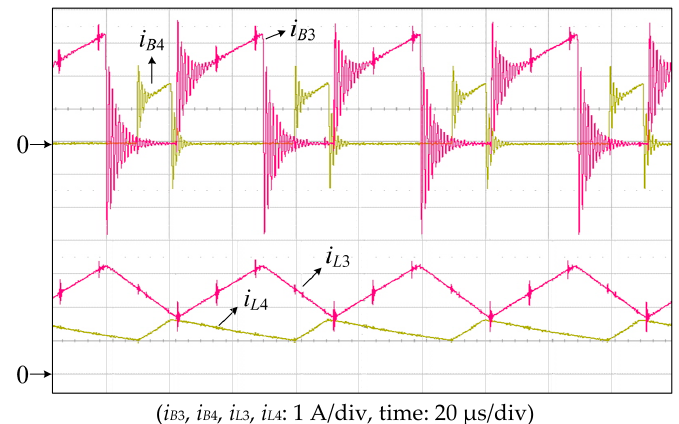
Figure 9. Battery and inductor currents during the balancing stage.